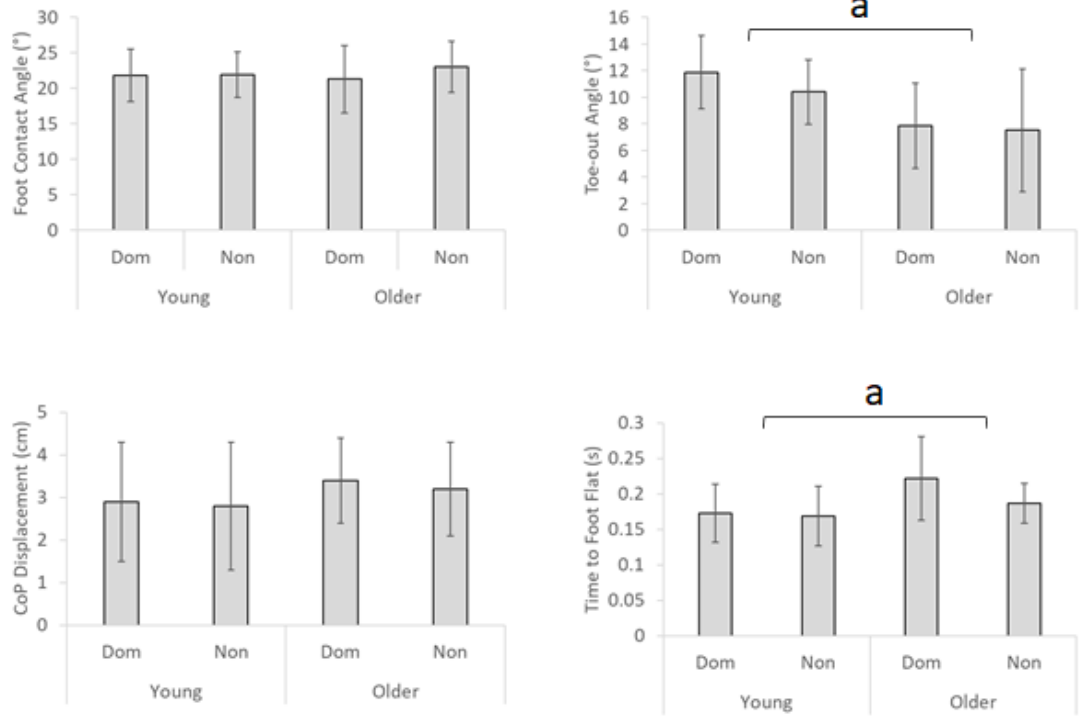
Figure 4. Foot Motion: (top left) foot contact angle; (bottom left) centre of pressure displacement; (top right) toe-out angle; (bottom right) time to foot flat, mean/SD; Dom/Non = dominant/non-dominant limb’s values; a = significant ageing effect, l = significant limb effect.